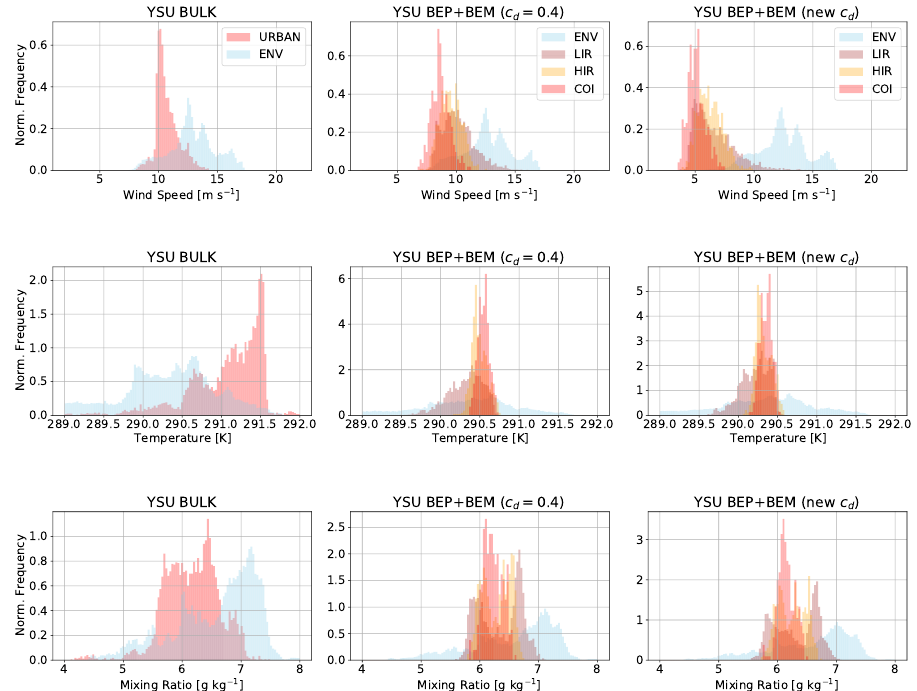
Figure 18. Same as Figure 17, but at 6:00 p.m. UTC 22 January (1:00 p.m. LST), afternoon in Houston near the time of peak winds after the cold front has